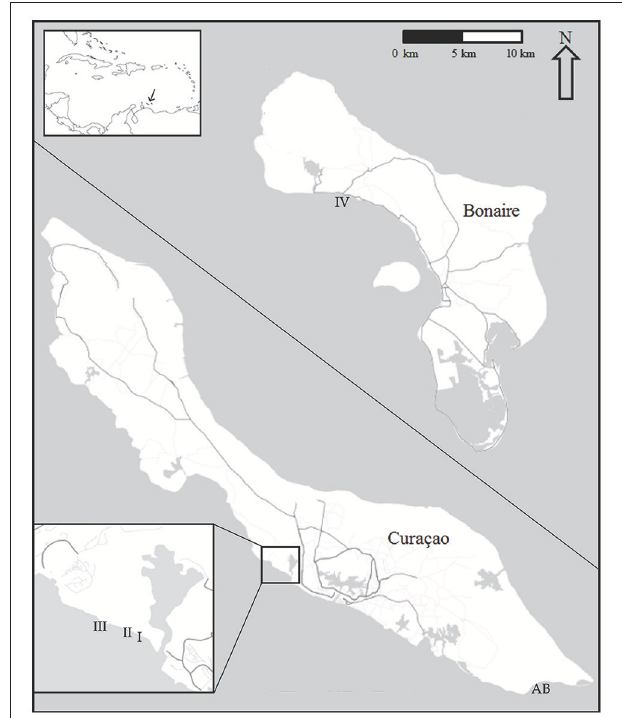
FIGURE 1 | Quadrat locations at Curaçao (I-III, AB) and Bonaire (IV). Including their position in the wider Caribbean sea (top left). Enlarged section at the lower left corner shows in detail the position of sites I-III on